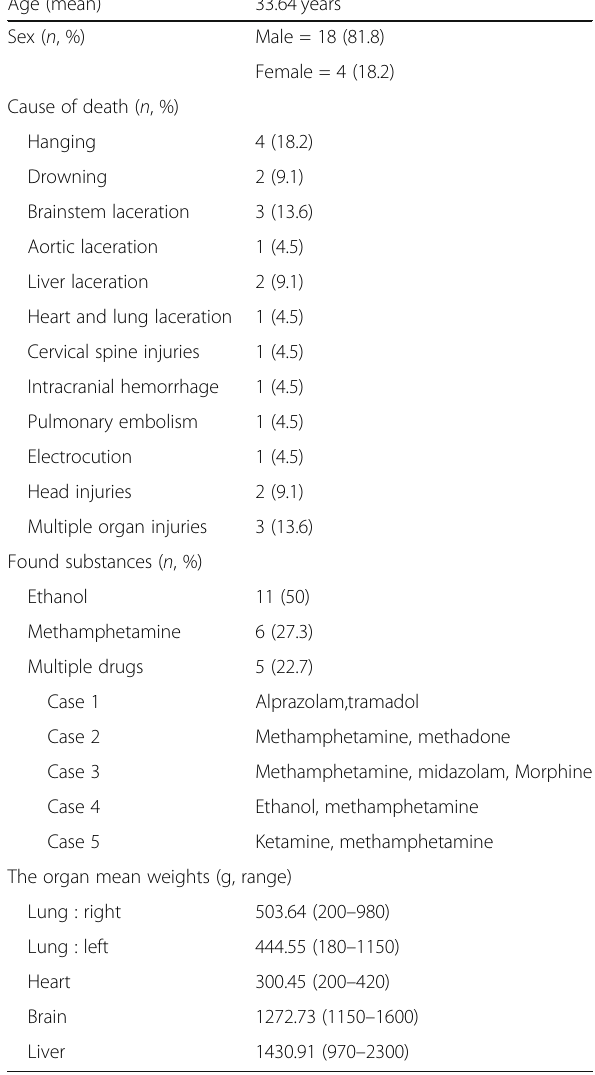
Table 4 The demographic data in the control group